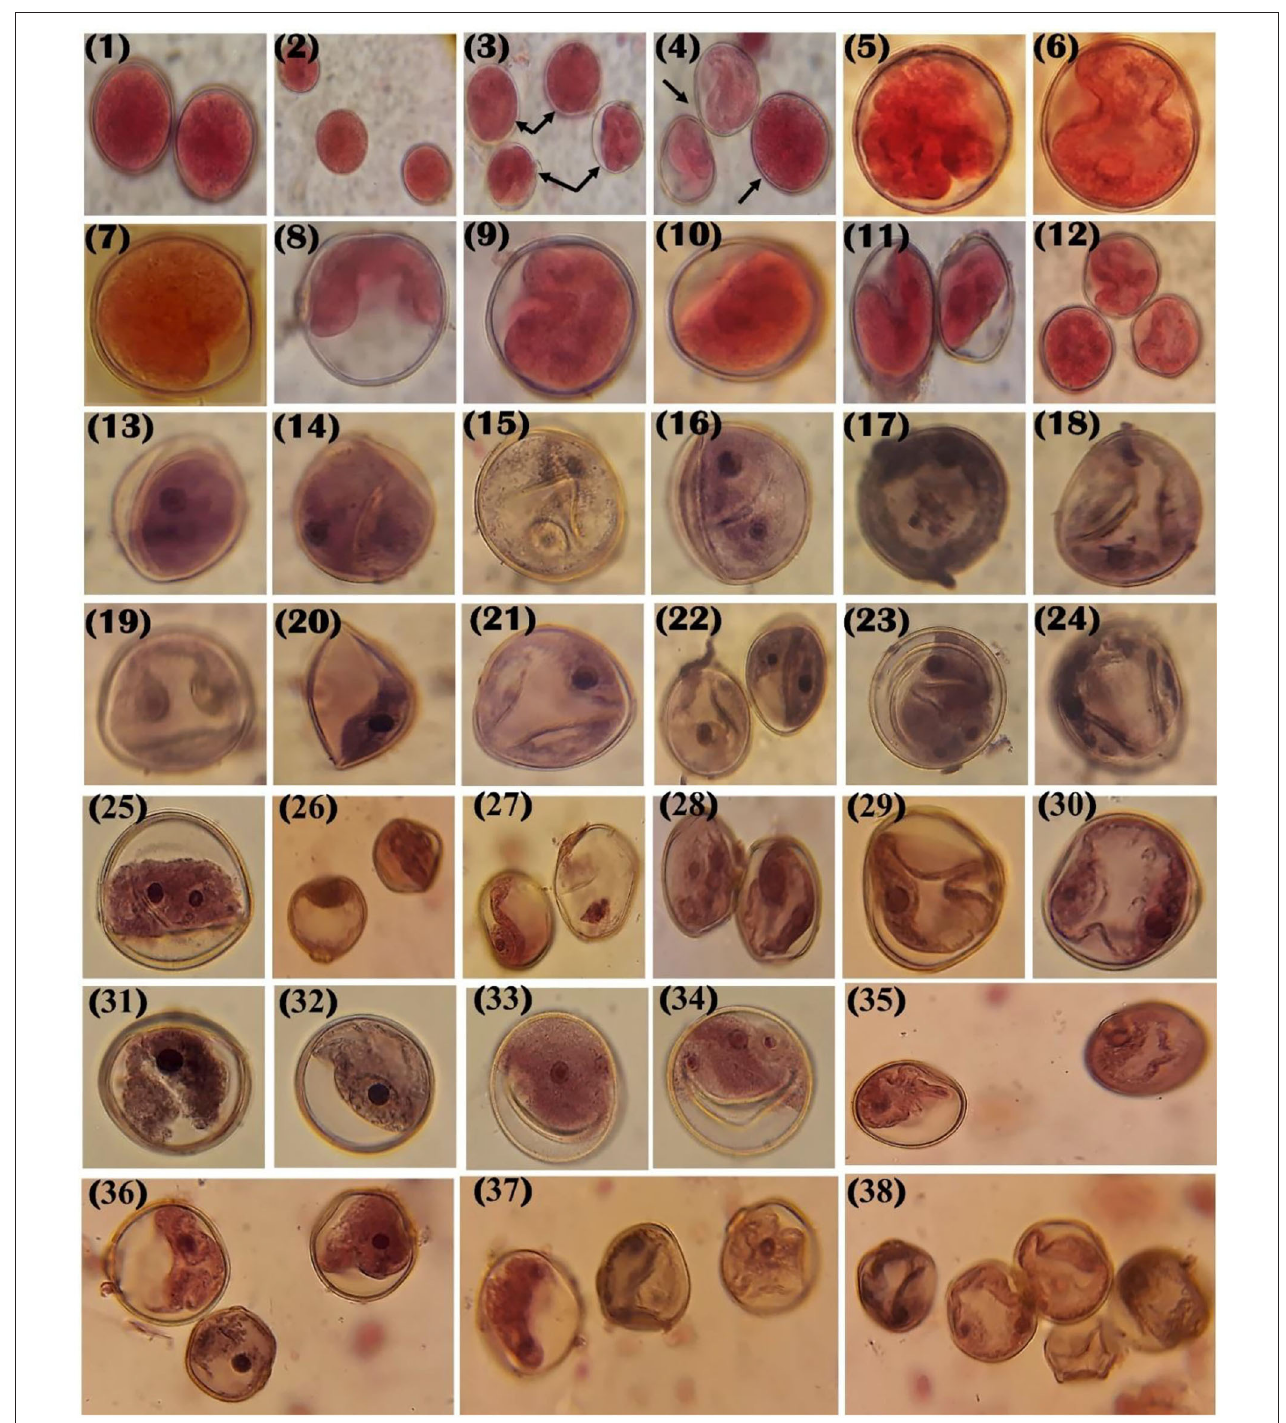
FIGURE 6 | Effect of Zn concentration (1,500, 2,000, and 2,500 mg/L) on pollen viability in rice cultivars (1–4) control showing completely fertile pollen grains (arrowheads) with full stanning and shape filled with normally stained starch in the rice cultivars Sakha1010, Skha178, Fourate, Yassimen, Amaber; (3–4) showing the difference between completely fertile and semifertile pollen grains in control; (5–12) pollens with stickiness, ultrastructural variations in the cell walls of the pollen grain, increase in ultrastructural variations ( ∼ 15:30%) in the exterior and interior walls, non-stained pollen grains with different aberrations such as stickiness, shrinkingly in pollen content with a large gap in capacity; (13–38) pollen grains with brown or light tan color (waxy); incompletely or fully degenerated content, and light red color and nearly 50:70% decrease in cytoplasm content, light red color and death of some parts in pollen grains, stickiness, and a big gap in pollen capacity.